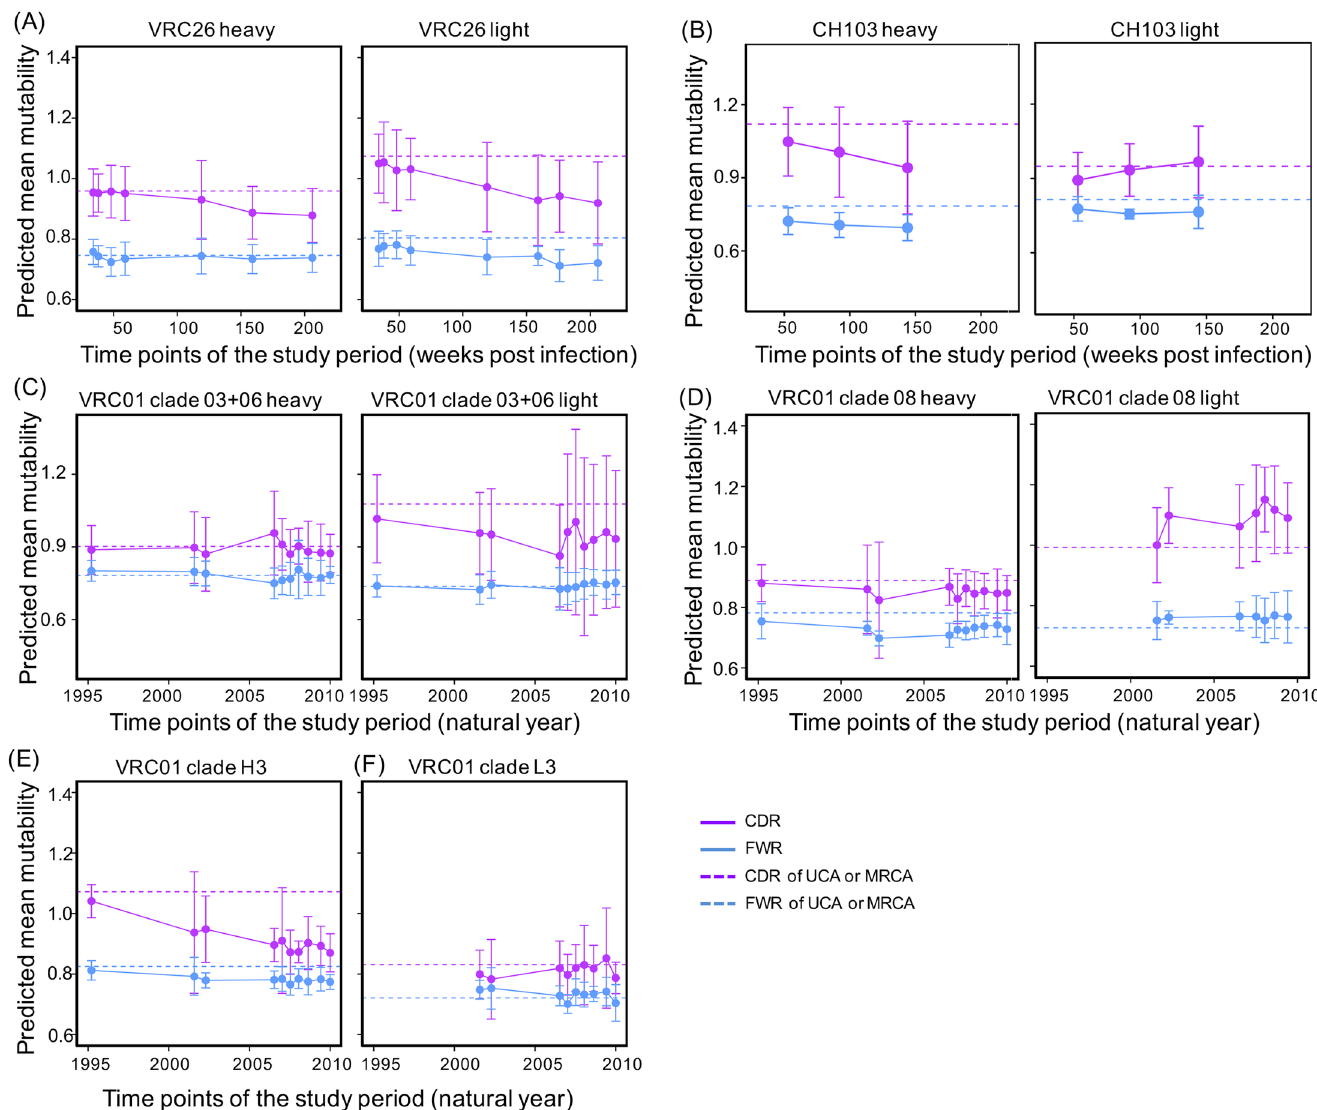
Fig 8. Dynamics of the predicted mutability for all time points of the three lineages. (A) Changes of predicted mutability of the VRC26 heavy (left) and light (right) chains. (B) Changes of predicted mutability of the CH103 heavy (left) and light (right) chains. (C) Changes of predicted mutability of the VRC01 clade 03+06 heavy (left) and light (right) chains. (D) Changes of predicted mutability of the VRC01 clade 08 heavy (left) and light (right) chains. (E) Changes of predicted mutability of the VRC01 clade H3. (F) Changes of predicted mutability of the VRC01 clade L3. Dashed line represents the mutability of UCA (VRC26 and CH103) or MRCA (VRC01 clades) of the lineages.